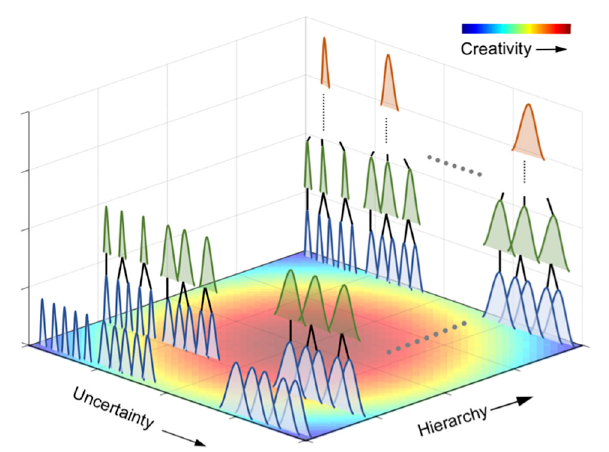
FIGURE 3 | A hypothesis of statistical creativity. Statistical creativity may, at least, be achieved via two potential mechanisms in a hierarchical statistical learning. The first is the interplay between the chunking of statistically coherent events into a unit and integration of the several units. This process forms a hierarchical structure in statistical learning (i.e., hierarchical statistical learning). The second is a perceptual uncertainty as shown in each of the bell-shaped distribution in the figure. The brain appears to seek a suboptimal solution of uncertainty for creativity based on prior distribution in the internal predictive model. It is assumed that a perceptual uncertainty at not very small- and large-scale statistical learning may induce statistical